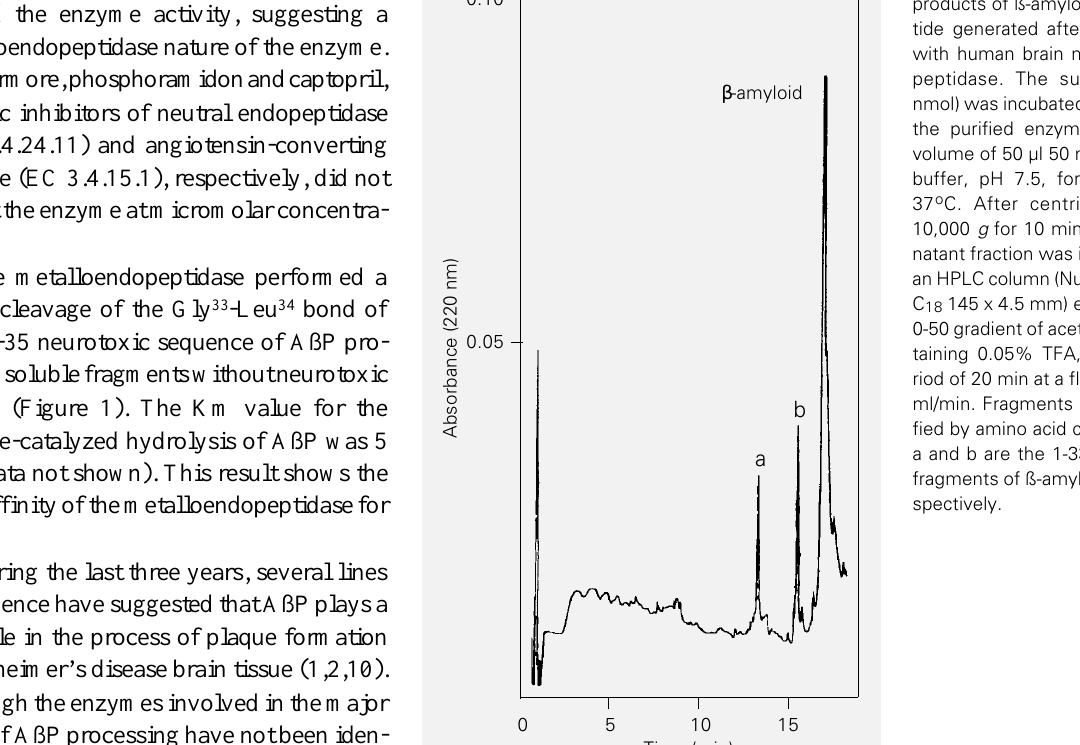
Figure 1 - HPLC elution profile of products of ß-amyloid 1-40 pep- tide generated after incubation with human brain metalloendo- peptidase. The substrate (20 nmol) was incubated with 5 µl of the purified enzyme in a final volume of 50 µl 50 mM Tris-HCl buffer, pH 7.5, for 30 min at 37 o C. After centrifugation at 10,000 g for 10 min, the super- natant fraction was injected into an HPLC column (Nucleosil 5 µm C 18 145 x 4.5 mm) eluted with a 0-50 gradient of acetonitrile con- taining 0.05% TFA, over a pe- riod of 20 min at a flow rate of 1 ml/min. Fragments were identi- fied by amino acid composition: a and b are the 1-33 and 34-40 fragments of ß-amyloid 1-40, re-